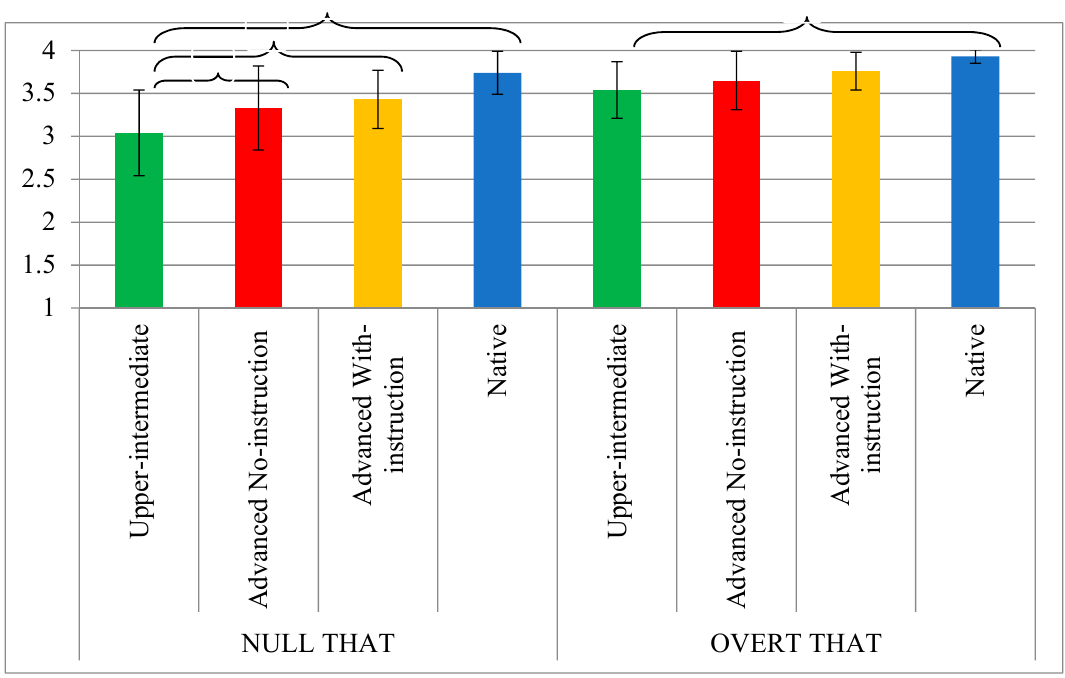
Figure 1. Acceptability rates by group and condition.